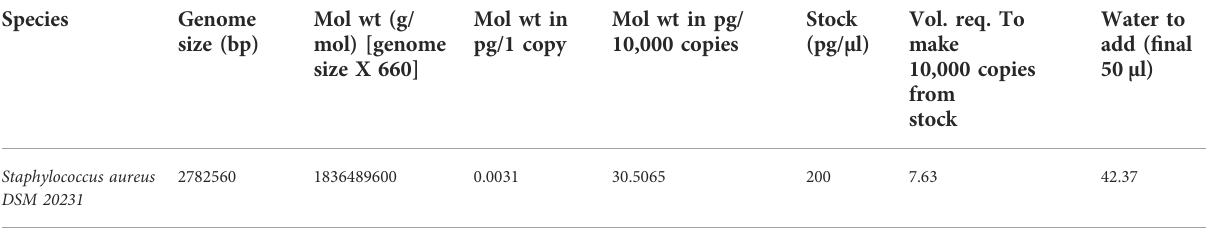
TABLE 1 Calculation of dilution factor for preparing genomic copy number dilutions from genome size and molecular weight of respective species a detailed table is provided as Supplementary Table S3. Species